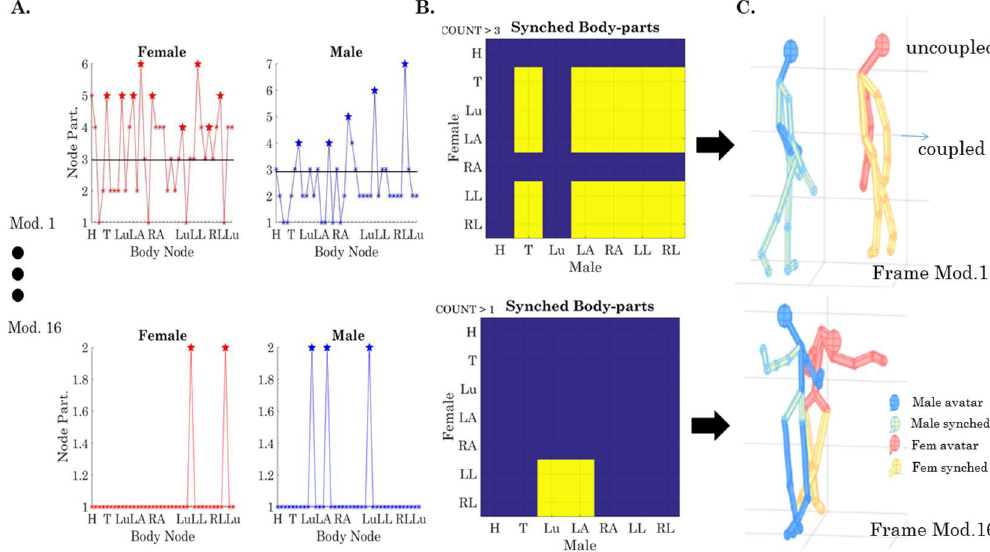
Figure 9. The automatic extraction of coupled synergistic behavior from the modules that self-emerge in the network’s dynamic evolution. ( A ) Simultaneous node participation in a given network module is tallied and threshold set to 1 ⁄ 2 the minimum of maximal participation. Such points count as coupled behavior for body segments that are comprised of such nodes. ( B ) Matrix representing the coupled behavior (yellow) across body regions of the two dancers. ( C ) Avatar representation of the coupled behavior. Blue (male) and red (female) with yellow segments colored from module to module. See Videos S2 and S3 showing full movies module by module and Video S4 showing the real-time dance video segment with the avatar representation.